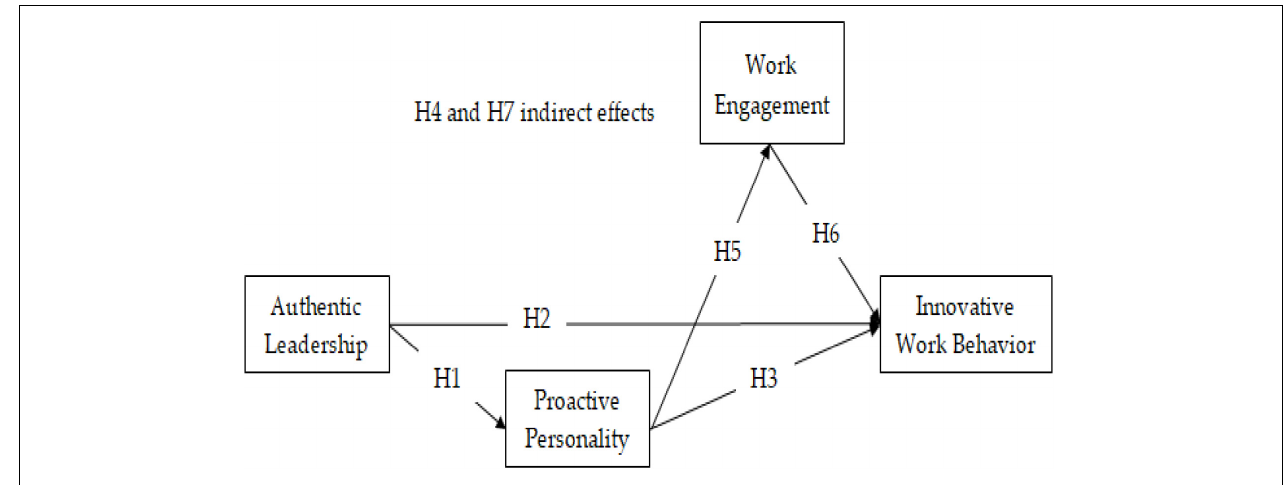
FIGURE 1 | Conceptual